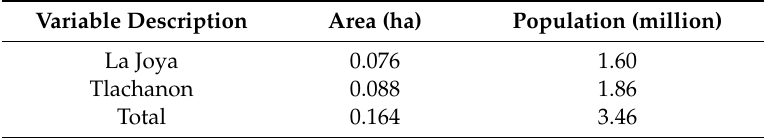
Table 7. Rough estimate of population density of monarch butterflies at the study